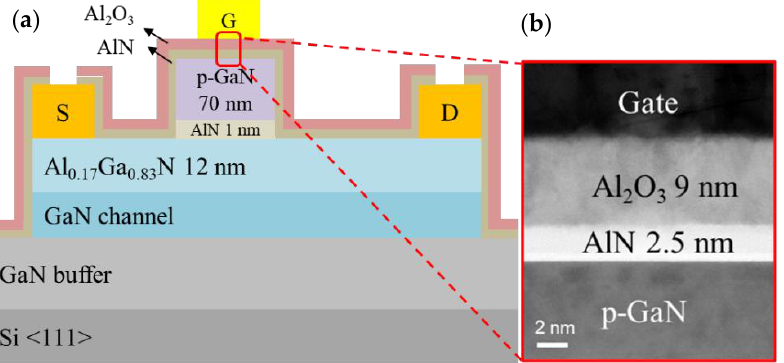
Figure 1. ( a ) Schematic of the device structure with L GS /L G /L GD /W G = 2/4/10/100 µ m. ( b ) trans- mission electron microscopy (TEM) photograph of the